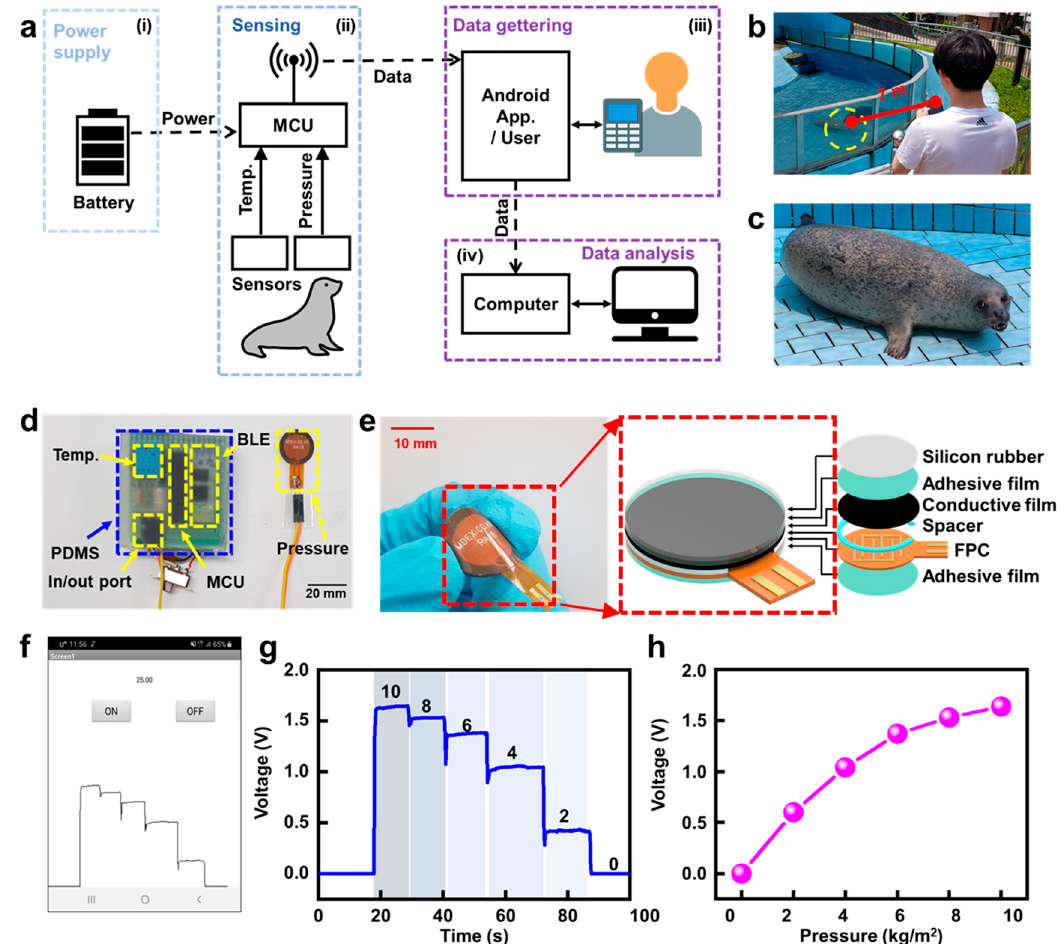
Figure 1. ( a ) Block diagrams for remote recognition systems: (i) power supply allowing the monitoring of moving behaviors on captive harbor seals (HS) via wireless data gathering through Bluetooth communication to a smartphone (user), (ii) microcontroller unit connected to sensors, (iii) example of data gathering using an Android application, and (iv) computer systems for data analysis. ( b ) Real-time image capturing the gathering of sensing data from captive harbor seals (distance ≈ 7 m). ( c ) Posture image of HS. ( d ) Optical images for implemented remote recognition systems, encapsulated with polydimethylsiloxane (PDMS) for waterproofing. ( e ) Optical image for flexible pressure sensors and exploded views of their assembly. ( f ) Representative image showing smartphone screen during the real-time monitoring of sensing data. ( g ) Graph of voltage vs. time during real-time monitoring. ( h ) Output voltage of pressure sensor, corresponding to various pressures ranging from 0 to 10 kg/m 2 .